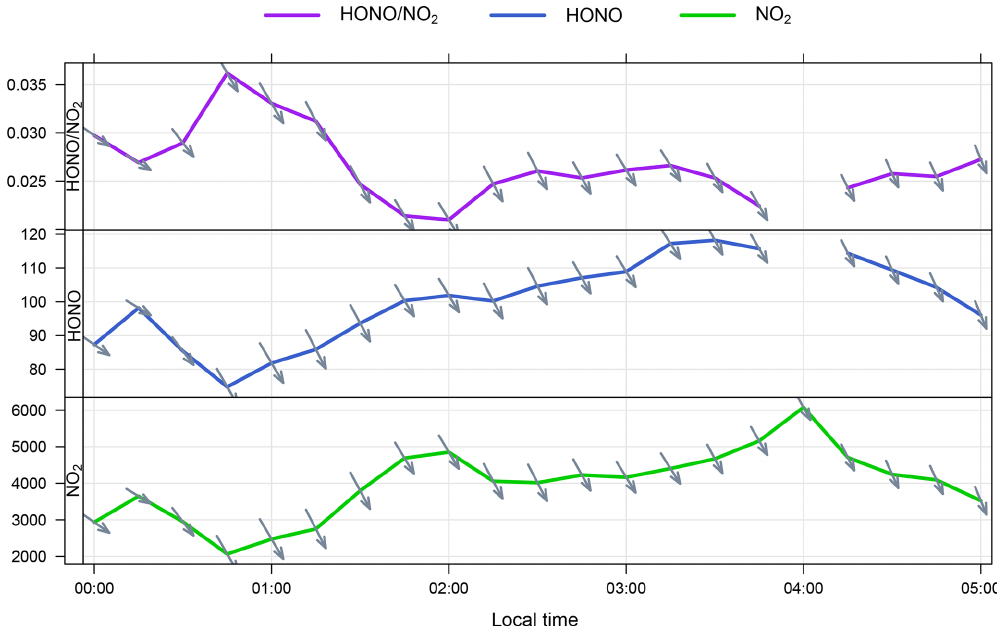
Figure 6. Time series of HONO / NO 2 , HONO (ppt) and NO 2 (ppt) at WAO on the night of 2–3 July. The arrows indicate the local wind direction – the marine sector spans WNW–ENE from the WAO station. The break in the HONO time series at 04:00LT is due to LOPAP